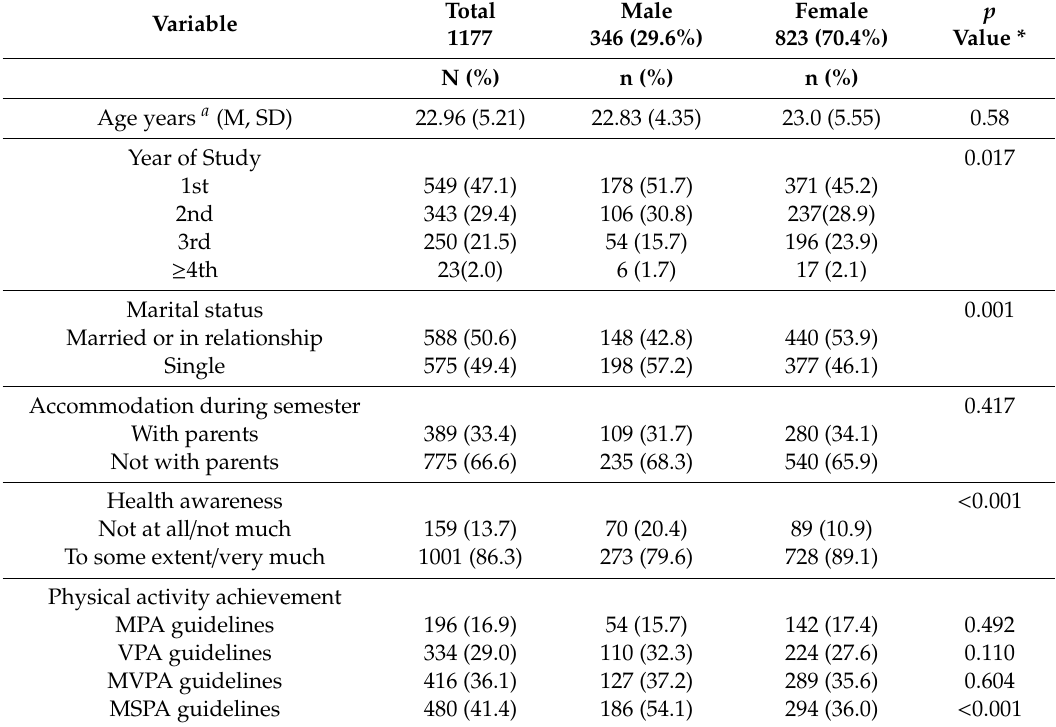
Table 1. Socio-demographic and physical activity achievement by gender among undergraduates, University of Turku, Finland (N =